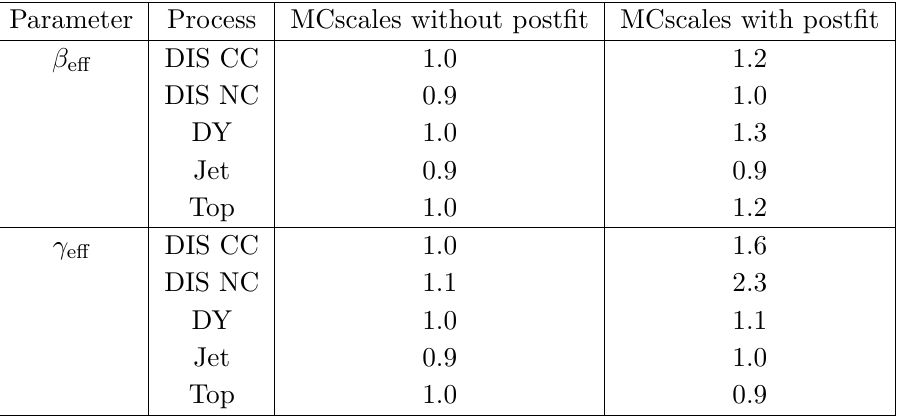
Table 8 . Estimates of the effective values of β and γ per process. Note that α is not shown because it does not differ between processes. Note also that the results for the MCscales set without postfit should each be equal to one in the limit of infinite statistics, and that the reason they are not is due to insufficient PDF